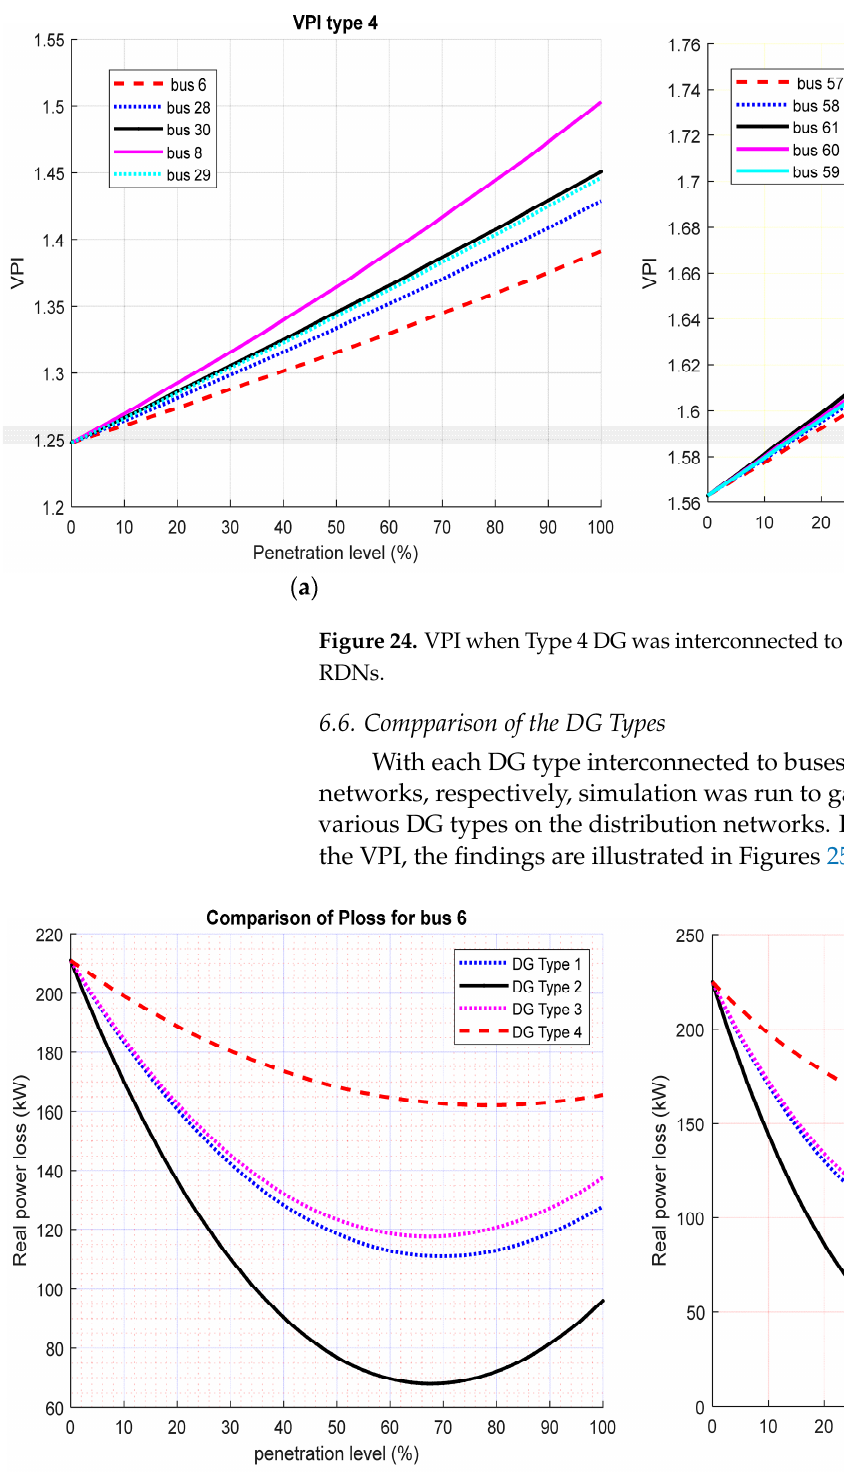
Figure 26. Comparison of reactive power loss by different DG types interconnected to ( a ) bus 6 of IEEE 33-bus and ( b ) bus 61 of the IEEE 69-bus RDNs.